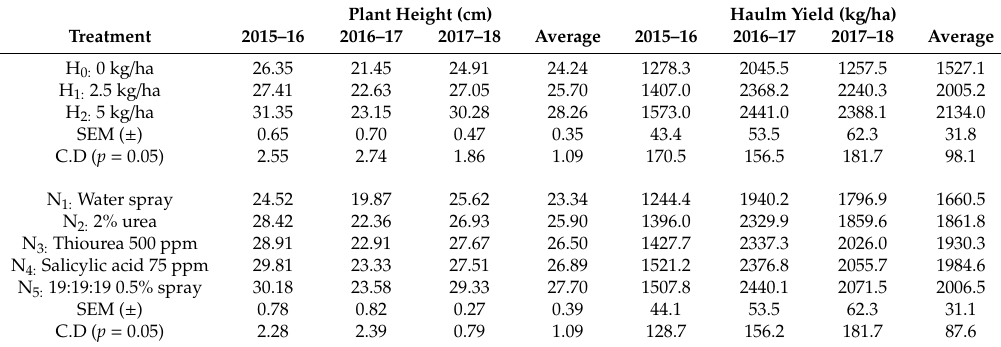
Table 3. Plant height and haulm yield (kg / ha) of lentil as influenced by di ff erent levels of hydrogel and foliar